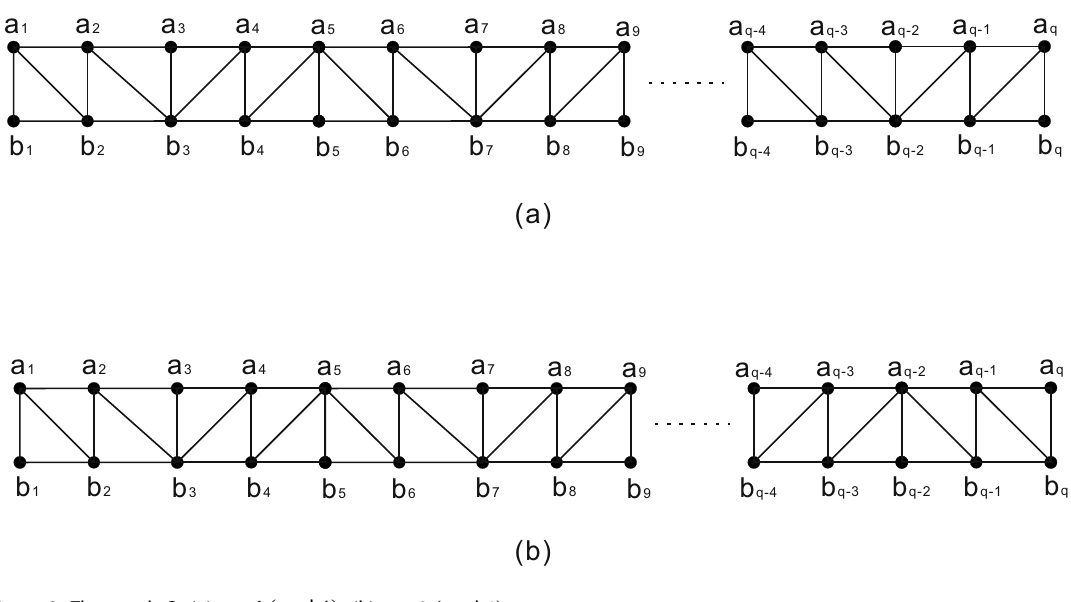
Figure 3: The graph G . ( a